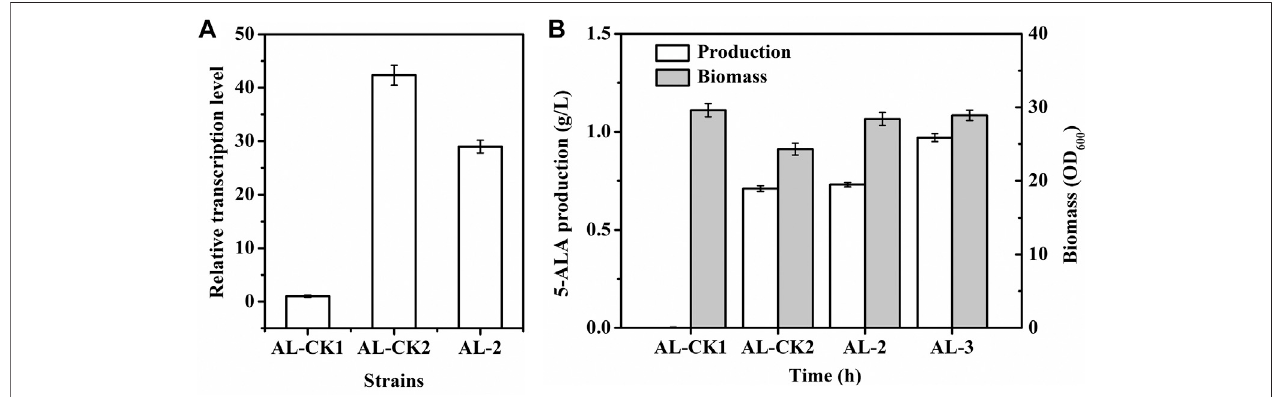
FIGURE 7 | 5-ALA production, biomass, and hemA M transcription of strains. (A) hemA M transcription; (B) 5-ALA production (white) and biomass (gray). AL-CK1 was used as a control. AL-CK1, AL-1 ( C. glutamicum Δ iolG Δ oxiC Δ oxiD Δ oxiE P ppc :P tuf P gltA :P tuf ) harboring pMI-4; AL-CK2, AL-1 harboring pAL1; AL-2, AL-1 harboring pMI-4- hemA M - hemL ; AL-3, C. glutamicum Δ iolG Δ oxiC Δ oxiD Δ oxiE P ppc :P tuf P gltA :P tuf cgl 2000 :P iolT1 - pntAB harboring pMI-4- hemA M - hemL